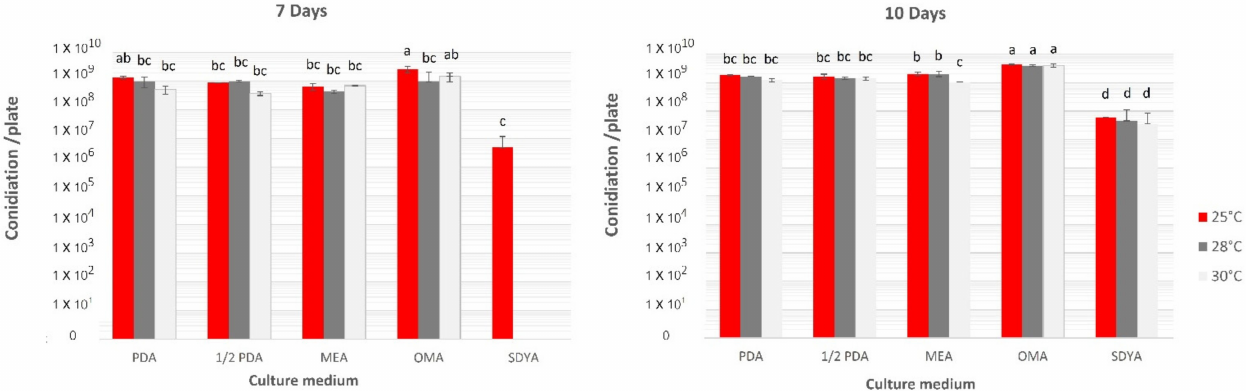
Figure 6. Conidiation of Metarhizium sp. BCC 4849 on difference culture media incubated at 25, 28, and 30 ◦ C at days 7 and 10. Data shown are mean ± s.e.m. Different letters indicate